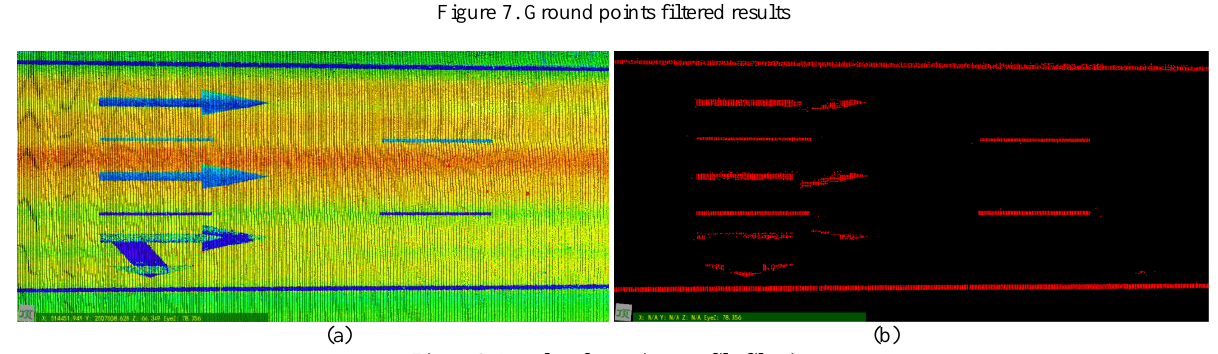
Figure 8. Results after points profile